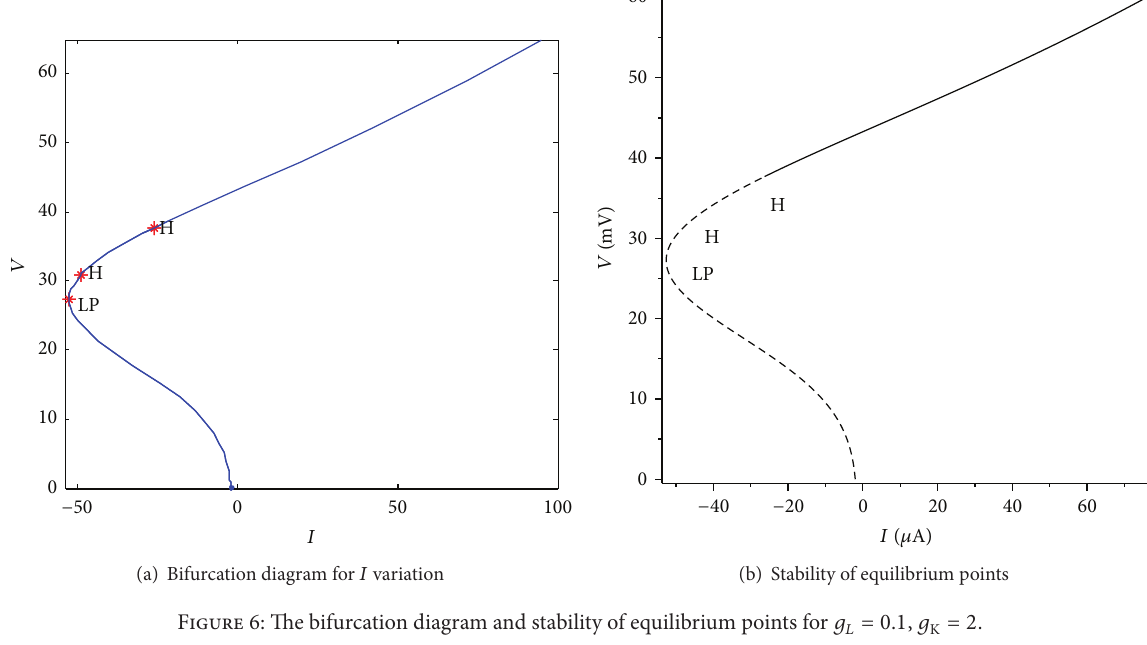
Figure 6: The bifurcation diagram and stability of equilibrium points for 𝑔 𝐿 = 0.1 , 𝑔